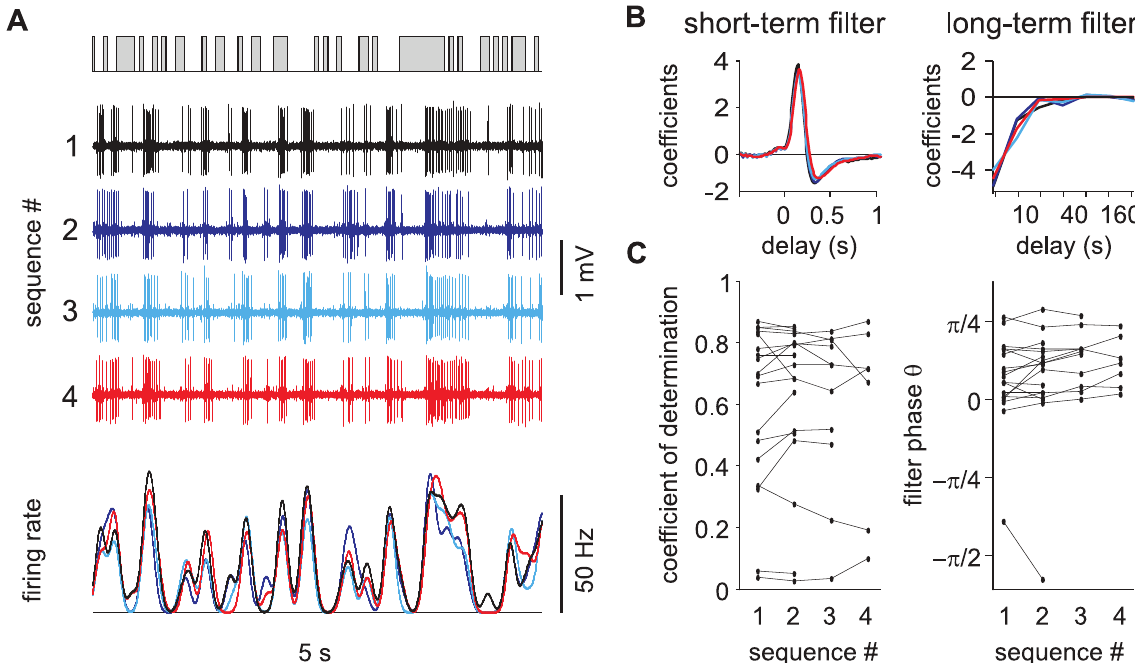
Fig 5. Stability of L-N model prediction for PNs. (A) Zoom on 4 consecutive responsesfrom a PN to a frozen white-noise. Top: stimulationsequence.Middle:action potential recordings.Bottom: recordedfiring rates. (B) Superimposed linear filters calculated independently for the same PN as in (A). (C) Distribution of the coefficient of determination and short-term filter phase for the 4 consecutive sequences.Same neuronvalues are joinedby line segments. There was no significantchangefor any parameter (cell number =